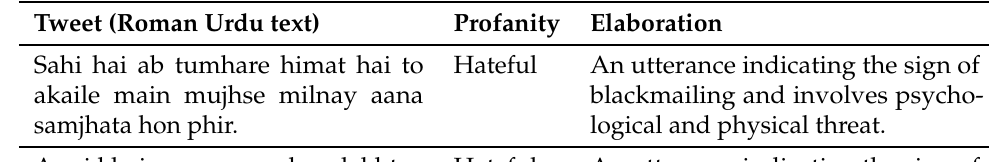
Table 2. Example of Roman Urdu instances from Roman Urdu corpora. Tweet (Roman Urdu text) Profanity Elaboration Hateful An utterance indicating the sign of blackmailing and involves psycho- logical and physical threat. Hateful